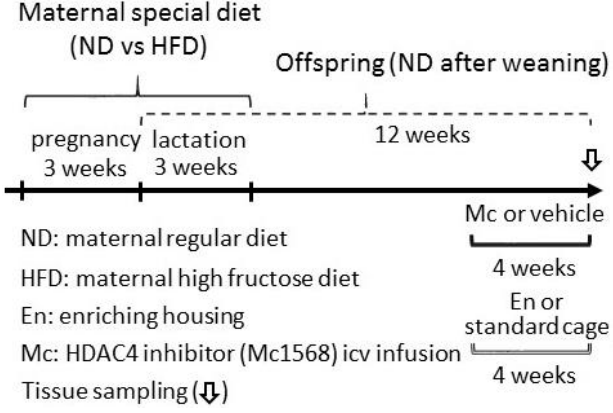
Figure 1. Schematic illustration of the study design. The hippocampal neural stem cell (NSC) proliferation and neuronal differentiation of adult female offspring from a regular maternal diet (ND) or maternal high-fructose diet (HFD) were assayed after 4 weeks of treatment. The treatments of the vehicle or Mc1568 (Mc) intraventricular infusion (icv) were conducted to evaluate the role of maternal diet-altered histone deacetylase 4 (HDAC4) in the adult neurogenesis in female offspring at 12 weeks old. Investigations into the differences between those housed in a standard cage and those housed in enriched housing (En) were conducted to evaluate the therapeutic effect of environmental enrichment on HDAC4-inhibited adult neurogenesis in female offspring at 12 weeks old.